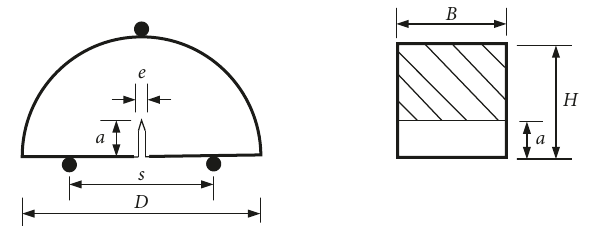
Figure 1: Schematic of the notched semicircular bend (NSCB) specimen. Note. a and e represent the length and width of the artificial notch, respectively; D , B , and H represent the diameter, thickness, and height of the specimen, respectively; s represent distance between the two supporting